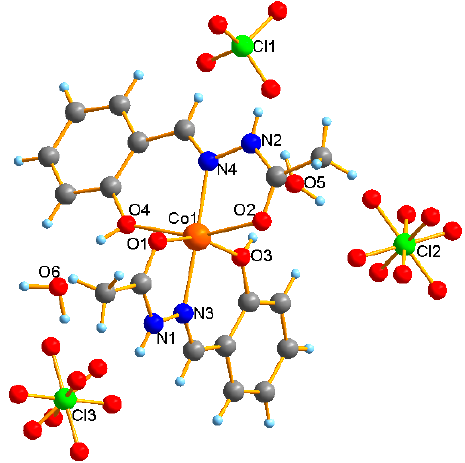
Figure 1. The asymmetric unit of complex 1 . Table 1. Selected bond distances (Å) and angles ( ° ) of 1 .